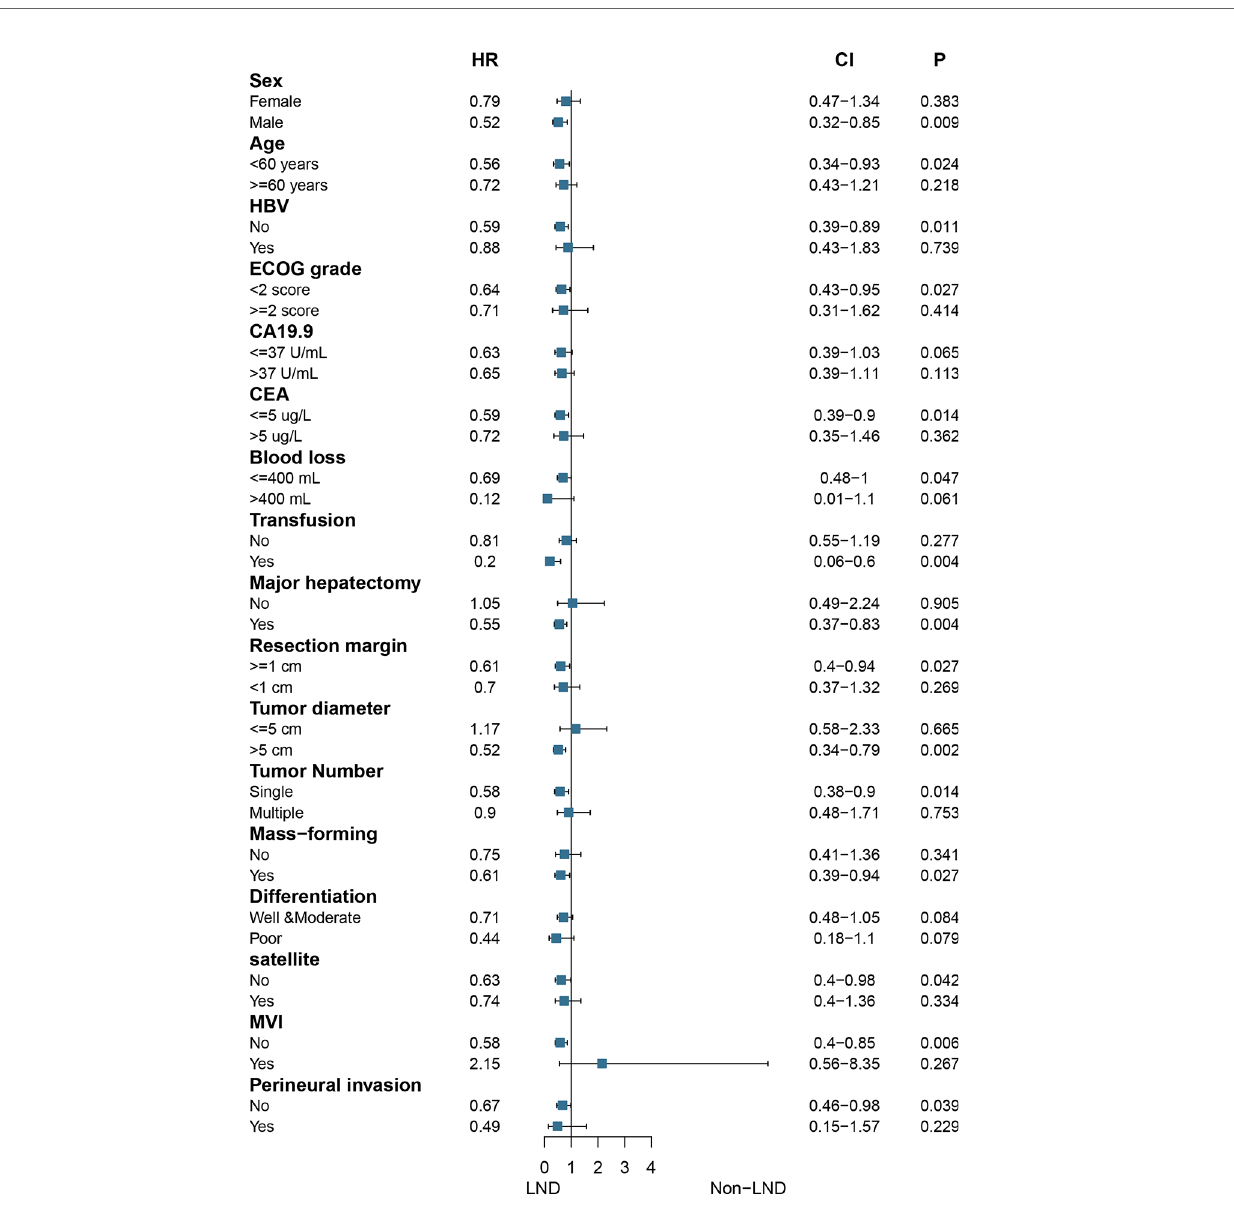
FIGURE 3 | Forest plot of subgroup analysis strati fi ed by risk factors in the matched